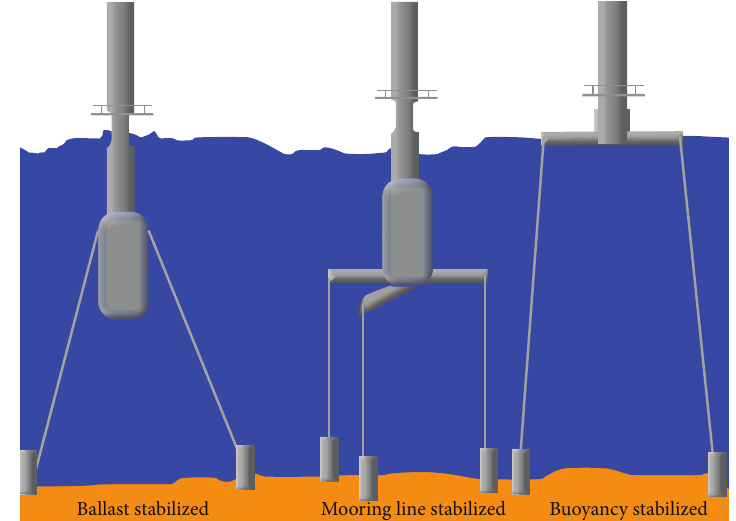
Figure 5: Several structures proposed for transition water depths